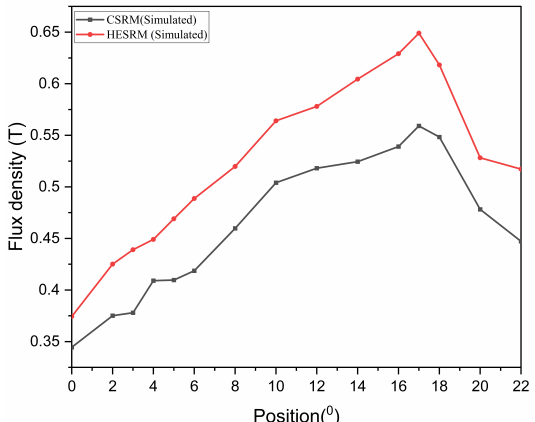
Figure 6. Simulated flux density of conventional SRM and the hybrid DC-excited SRM.